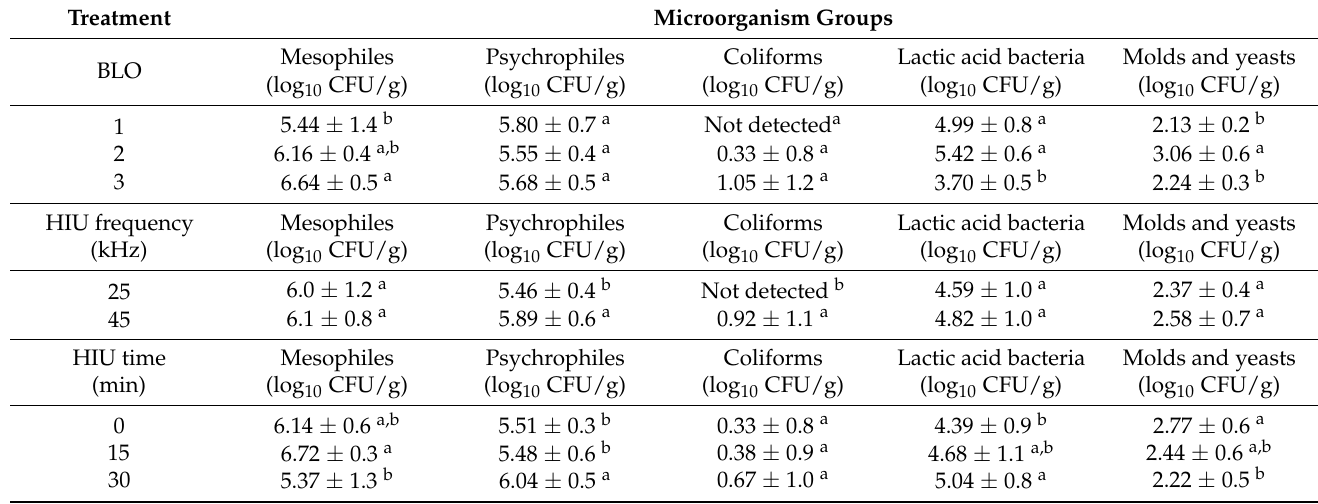
Table 4. Effects of blocks (BLO), HIU frequency and HIU applied time on the mesophiles, psy- chrophiles, coliform, lactic acid bacteria and molds and yeasts counts of Oaxaca